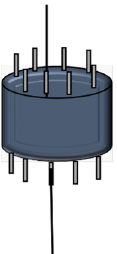
Figure 4. Schematic of a microsphere holder holding a single microsphere. This rubber stopper may then be placed inside a glass jar, suspending the microspheres in the solution without touching the side of the jars. This minimizes the possibility of damaging the microspheres due to handling. Up to eight microspheres may be suspended at once, although only one is shown here.